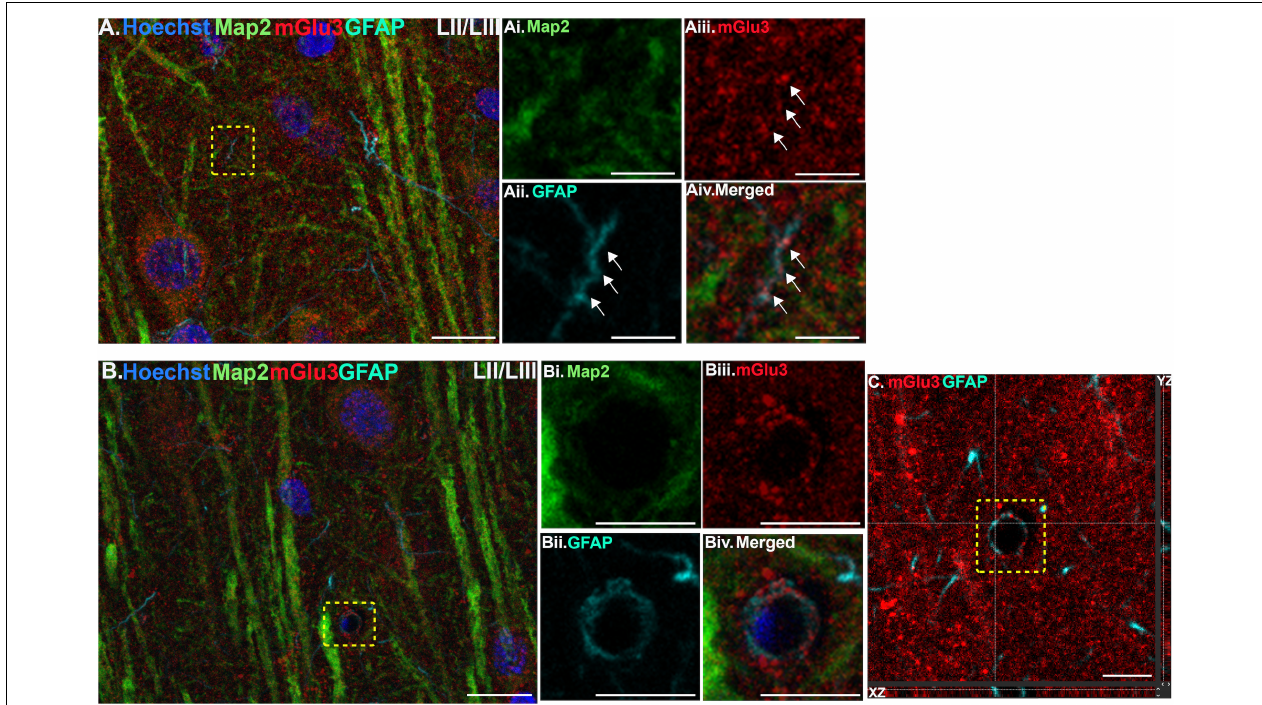
FIGURE 1 | Multiple label immunofluorescence of mGlu3 labeling in astrocytes in layer II/III of rat PL mPFC. Tissue was labeled with antibodies recognizing the astrocytic protein GFAP (cyan), mGlu3 (red), the dendritic marker Map2 (green), as well as the nuclear Hoechst stain (blue). (A) A region of layer II/III that is diffusely labeled for mGlu3. Map2 positive dendrites are positive for mGlu3. The yellow box demarcates a GFAP-positive astrocytic process. (Ai–iv) Magnified area outlined by the yellow box in A shows a thin astrocytic process (traced by the white arrows) that is mGlu3 and GFAP positive and Map2 negative. (B) Expression of mGlu3 (red) is evident in pyramidal-shaped neurons, as seen by co-localization of Map2 and mGlu3, and diffusely across the neuropil. There is a small blood vessel with a GFAP positive astrocytic process overlying the vasculature that contains mGlu3 labeling. (Bi–iv) Magnified area of the region delineated by the yellow box in (B) showing co-localization of mGlu3 (red) and GFAP (cyan) and the absence of Map2 (green) and Hoechst (blue), consistent with an astrocytic process. (C) Orthogonal sectioning of this region (corresponding region of interest from (B) outlined by the yellow box). Selected z-stack image shows co-localization of mGlu3 and GFAP (red and cyan) across three different planes for one point, as indicated by the crossed dashed lines. The right-side bar demonstrates labeling in the YZ plane, while the bottom bar represents labeling in the XZ plane. Scale bars: 10 µ m (A,B) ; 2.5 µ m (Ai–iv) ; 5 µ m (Bi–iv) ; 5 µ m (C)